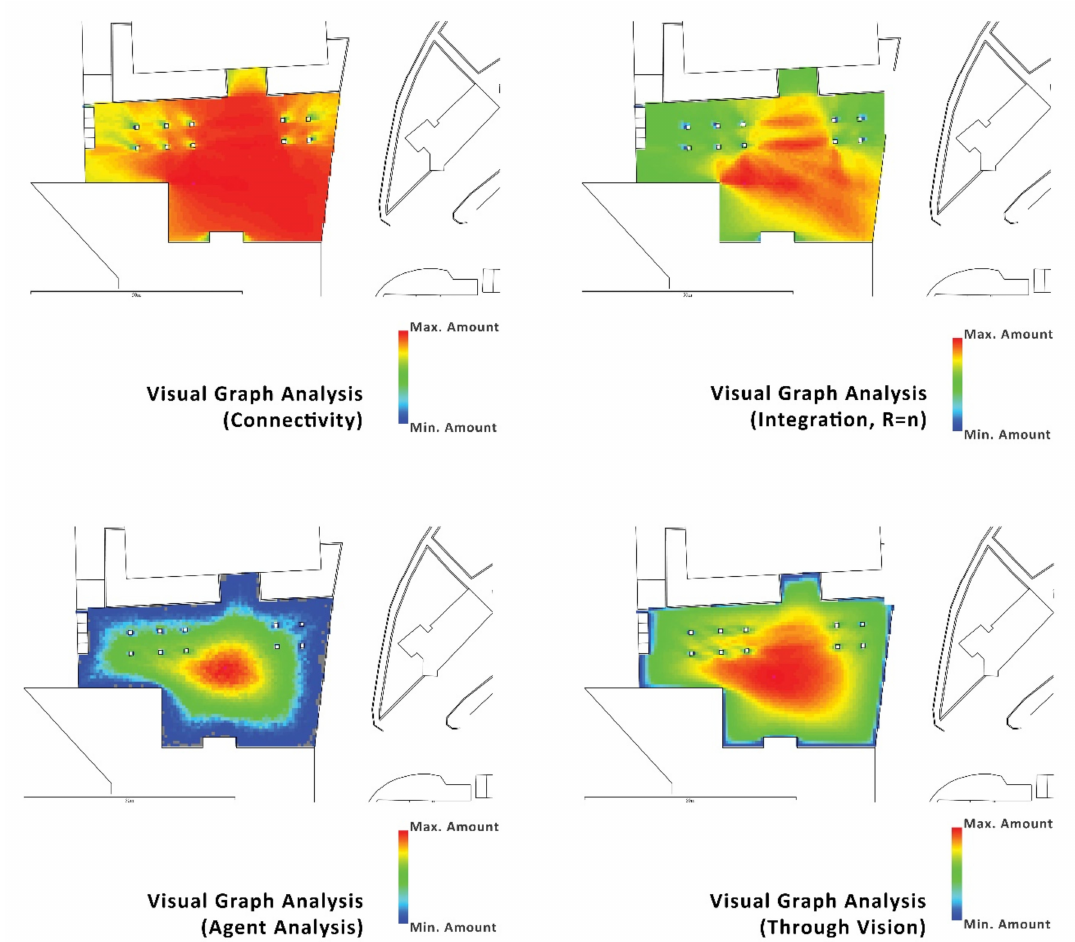
Figure 5. Visibility graph analysis (VGA) for open space 1.